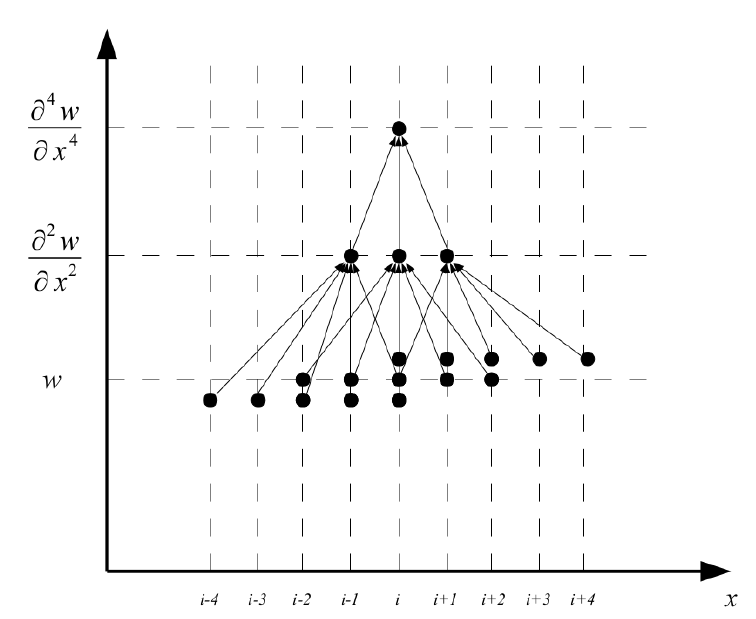
Figure 4. Fourth-order derivative bias stencil for good agreement with physical behaviour.